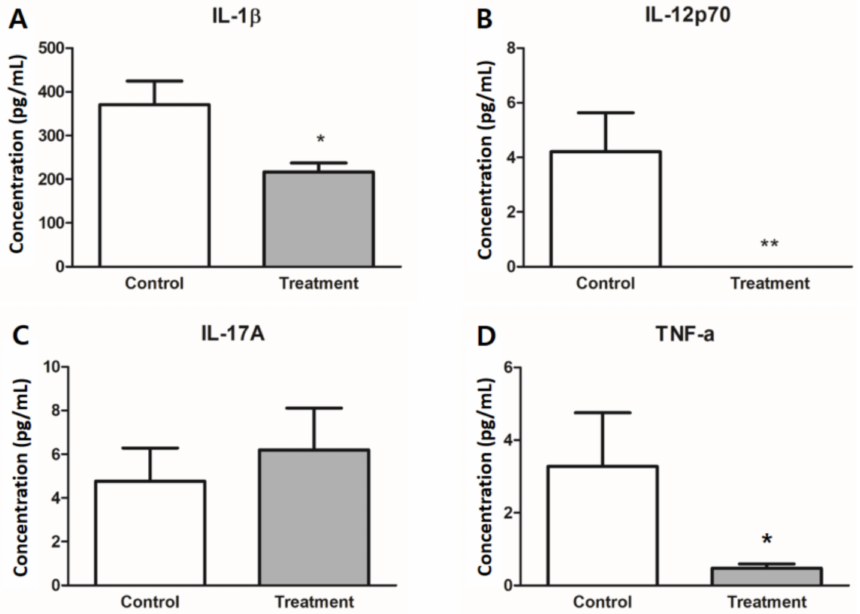
Figure 5. Inflammatory cytokines in colon tissue. Cytokine levels of ( A ) IL-1 β , ( B ) IL-12p70, ( C ) IL- 17A, and ( D ) TNF- α were measured in colon tissue after the four-week study regimen. IL-1 β , IL-12p70, and TNF- α were significantly lower in the treatment group (gray bar) than the control group (white bar). Results are expressed as the mean ± SEM ( n = 7/group). * Indicates significant differences by unpaired t -test; * p < 0.05, ** p <